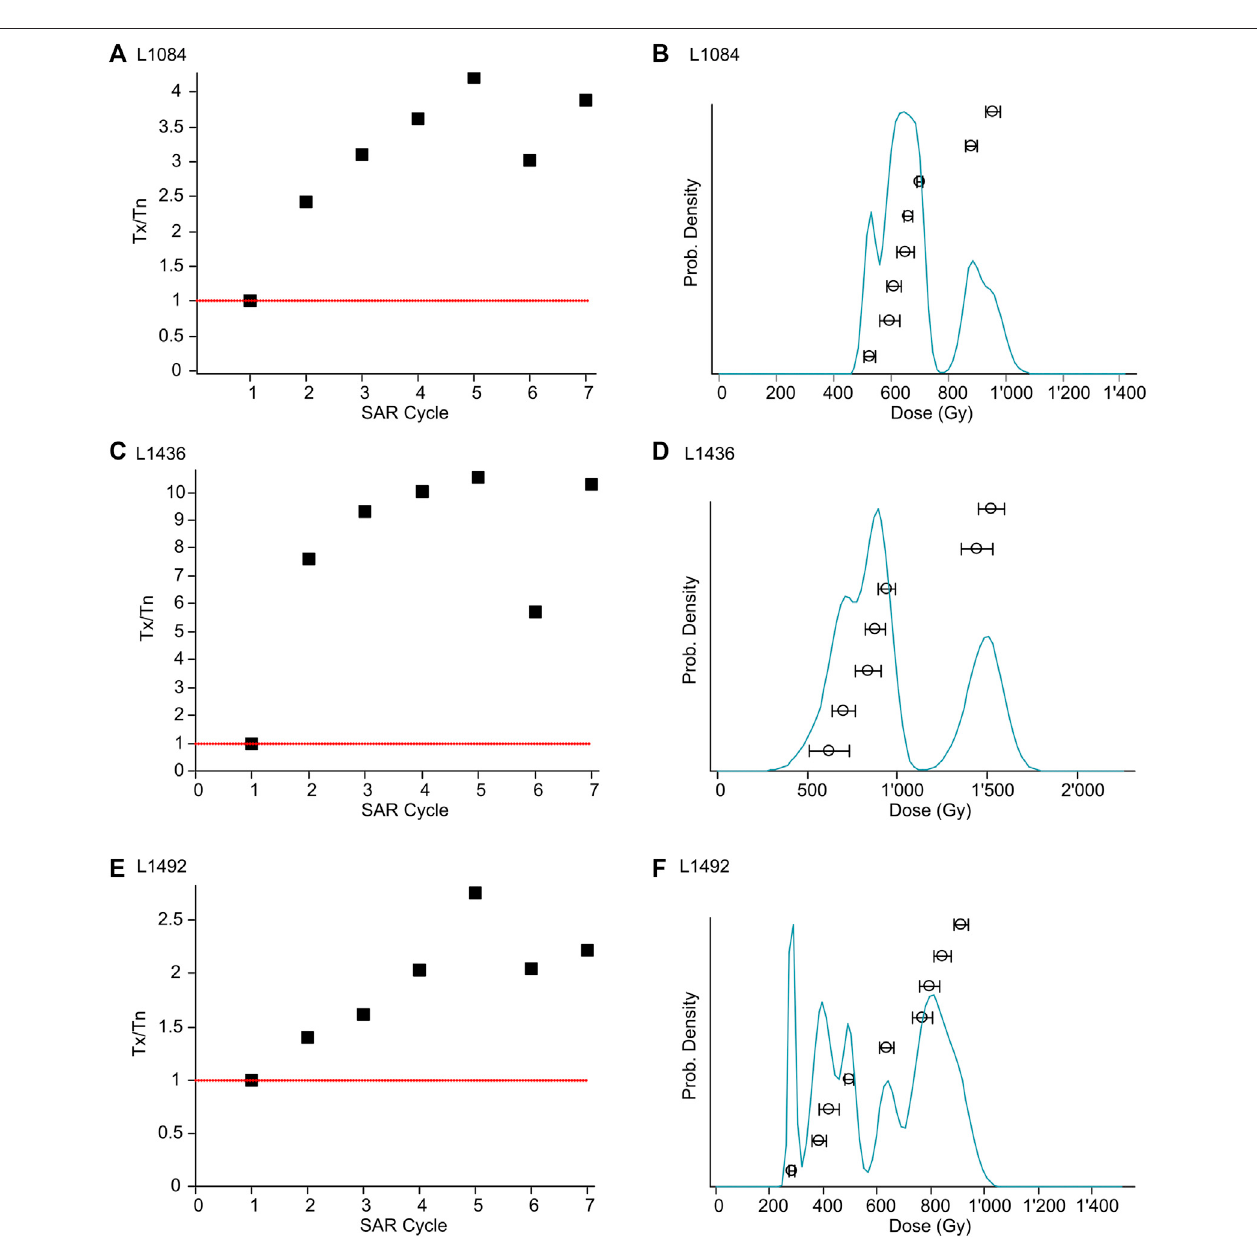
FIGURE 4 | Sensitivity changes over each SAR cycle and TT-OSL De distributions of representative samples AVA01E (L1084 - A,B ), AVA22A (L1436 - C,D ), and 155814 (L1492 - E,F ).